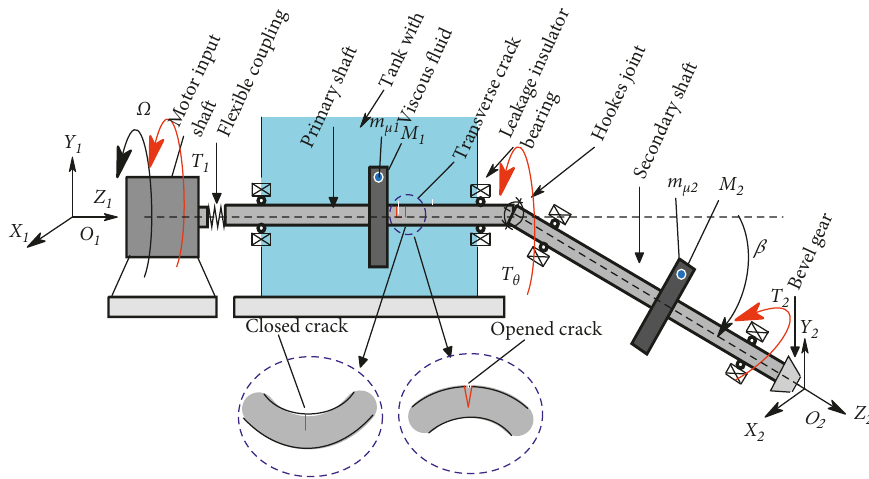
Figure 1: Physical description of a Cardan shaft system model partially submerged in a viscous fluid.